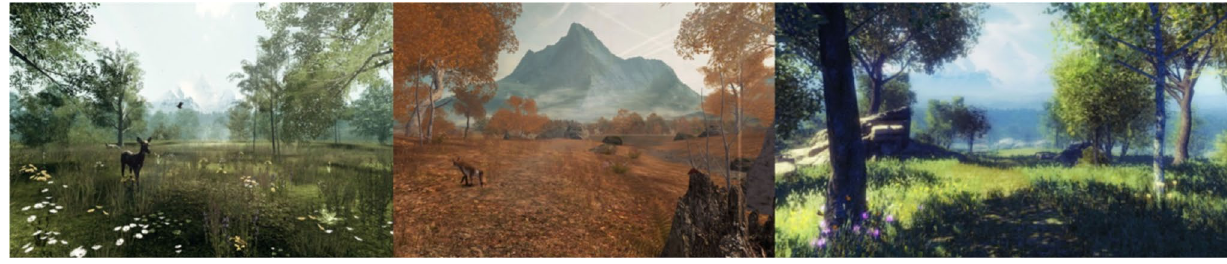
Figure 1. Nature treks